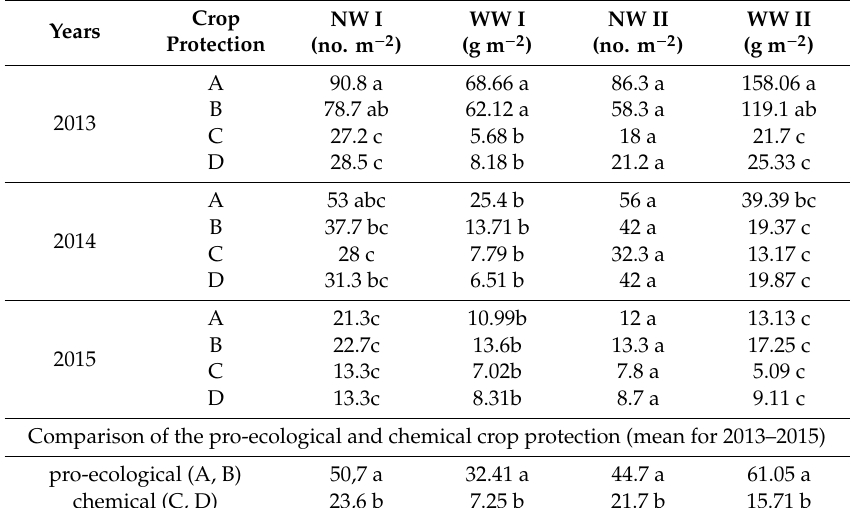
Table 2. The weed infestation indicators in the spelt wheat cv. “Rokosz” showing the interaction between crop protection and years of research, and comparison of the pro-ecological and chemical crop protection. NW I—number of weeds 3–4 weeks after herbicide treatment, WW I—air-dry weight of weeds 3–4 weeks after herbicide treatment, NW II—number of weeds at the dough stage of spelt wheat (BBCH 83–85), WW II—air-dry weight of weeds at the dough stage of spelt wheat (BBCH 83–85). Di ff erent letters denote significant di ff erences ( p ≤ 0.05). The same letter means not